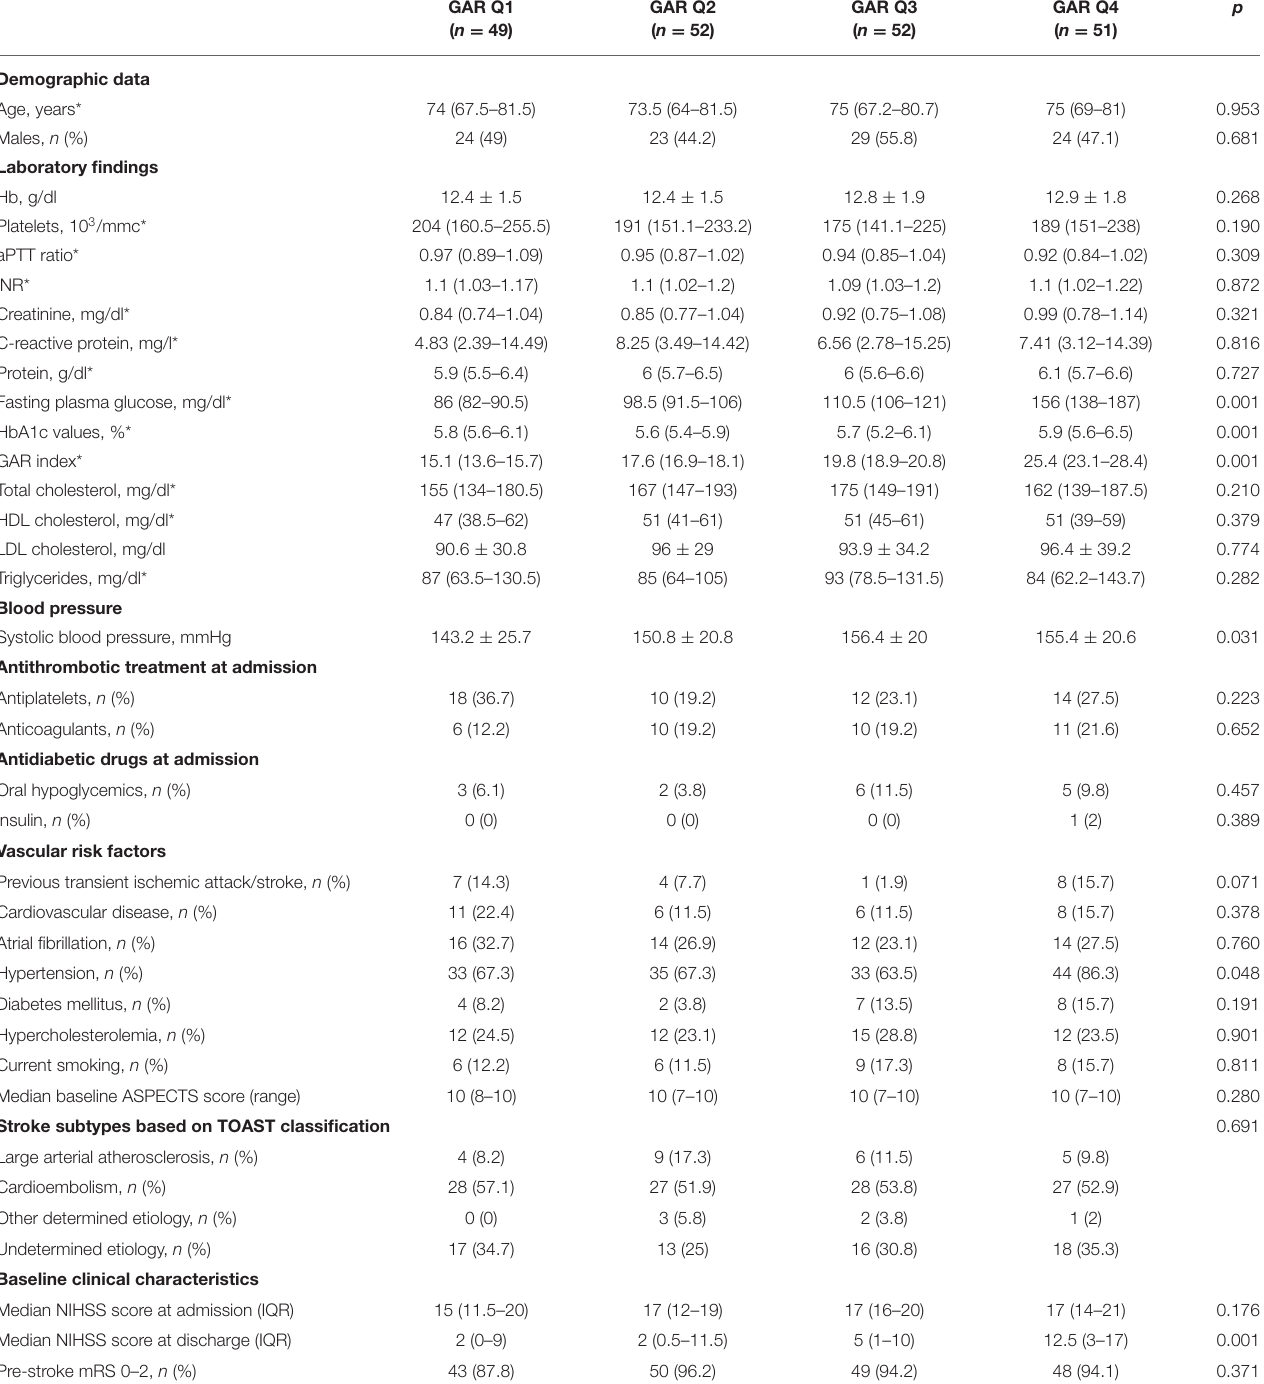
TABLE 1 | General characteristics of the subjects according to the GAR